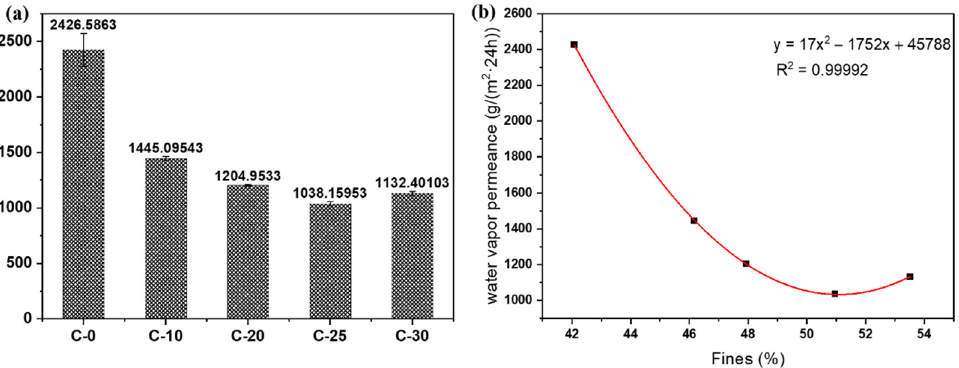
Figure 7. ( a ) Water vapor transmittance of nano/microfibrils films. ( b ) Fines (x) as a function of water vapor transmission rate (y). The solid line represents the nonlinear fit, with correlation coefficient R 2 =